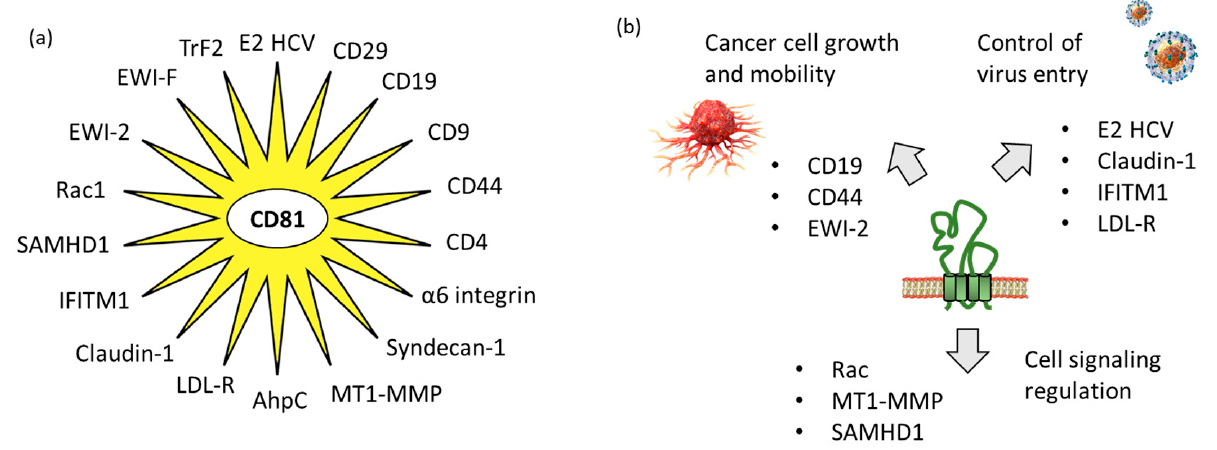
Figure 3. CD81 protein partners. ( a ) Multiple CD81-interacting proteins have been identified, including ten defined with the support of STRING database “https://cn.string-db.org/ (accessed on 1